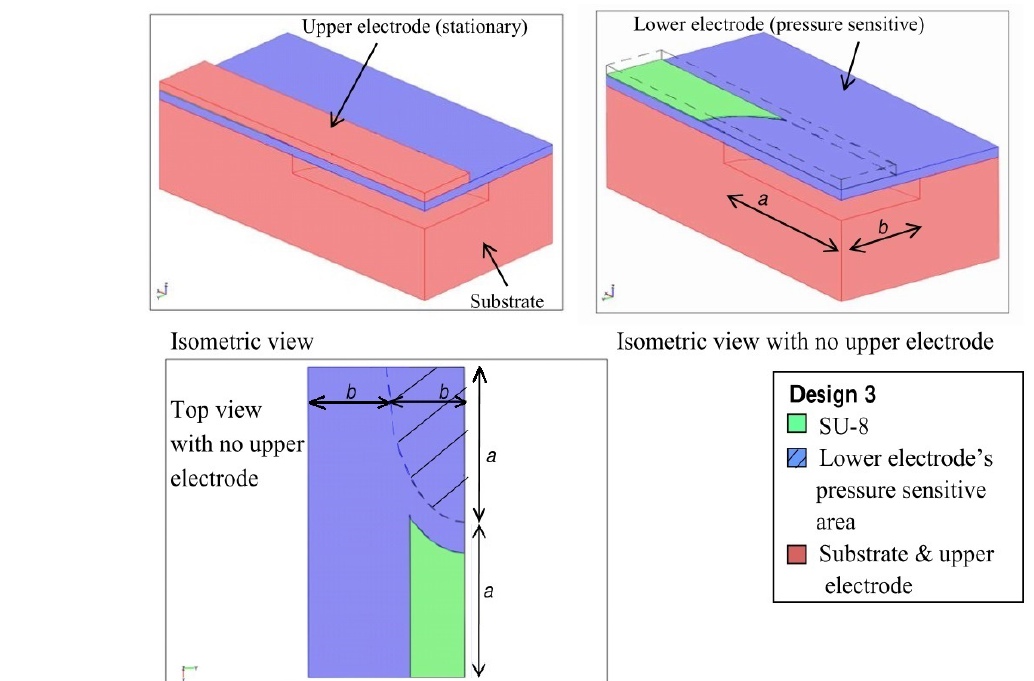
Figure 15. A three-dimensional view of a quarter of the narrowed elliptical diaphragm pressure